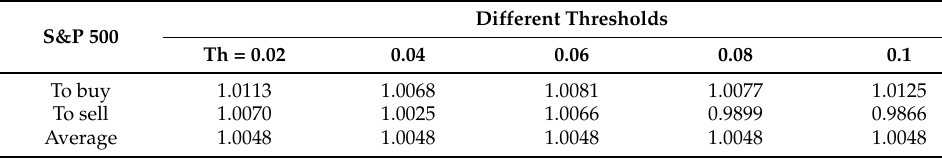
Table 5. Returns in S&P 500.